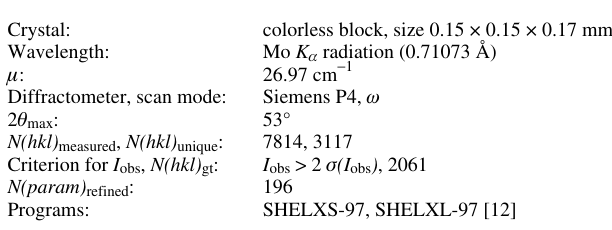
Table 1. Data collection and handling.